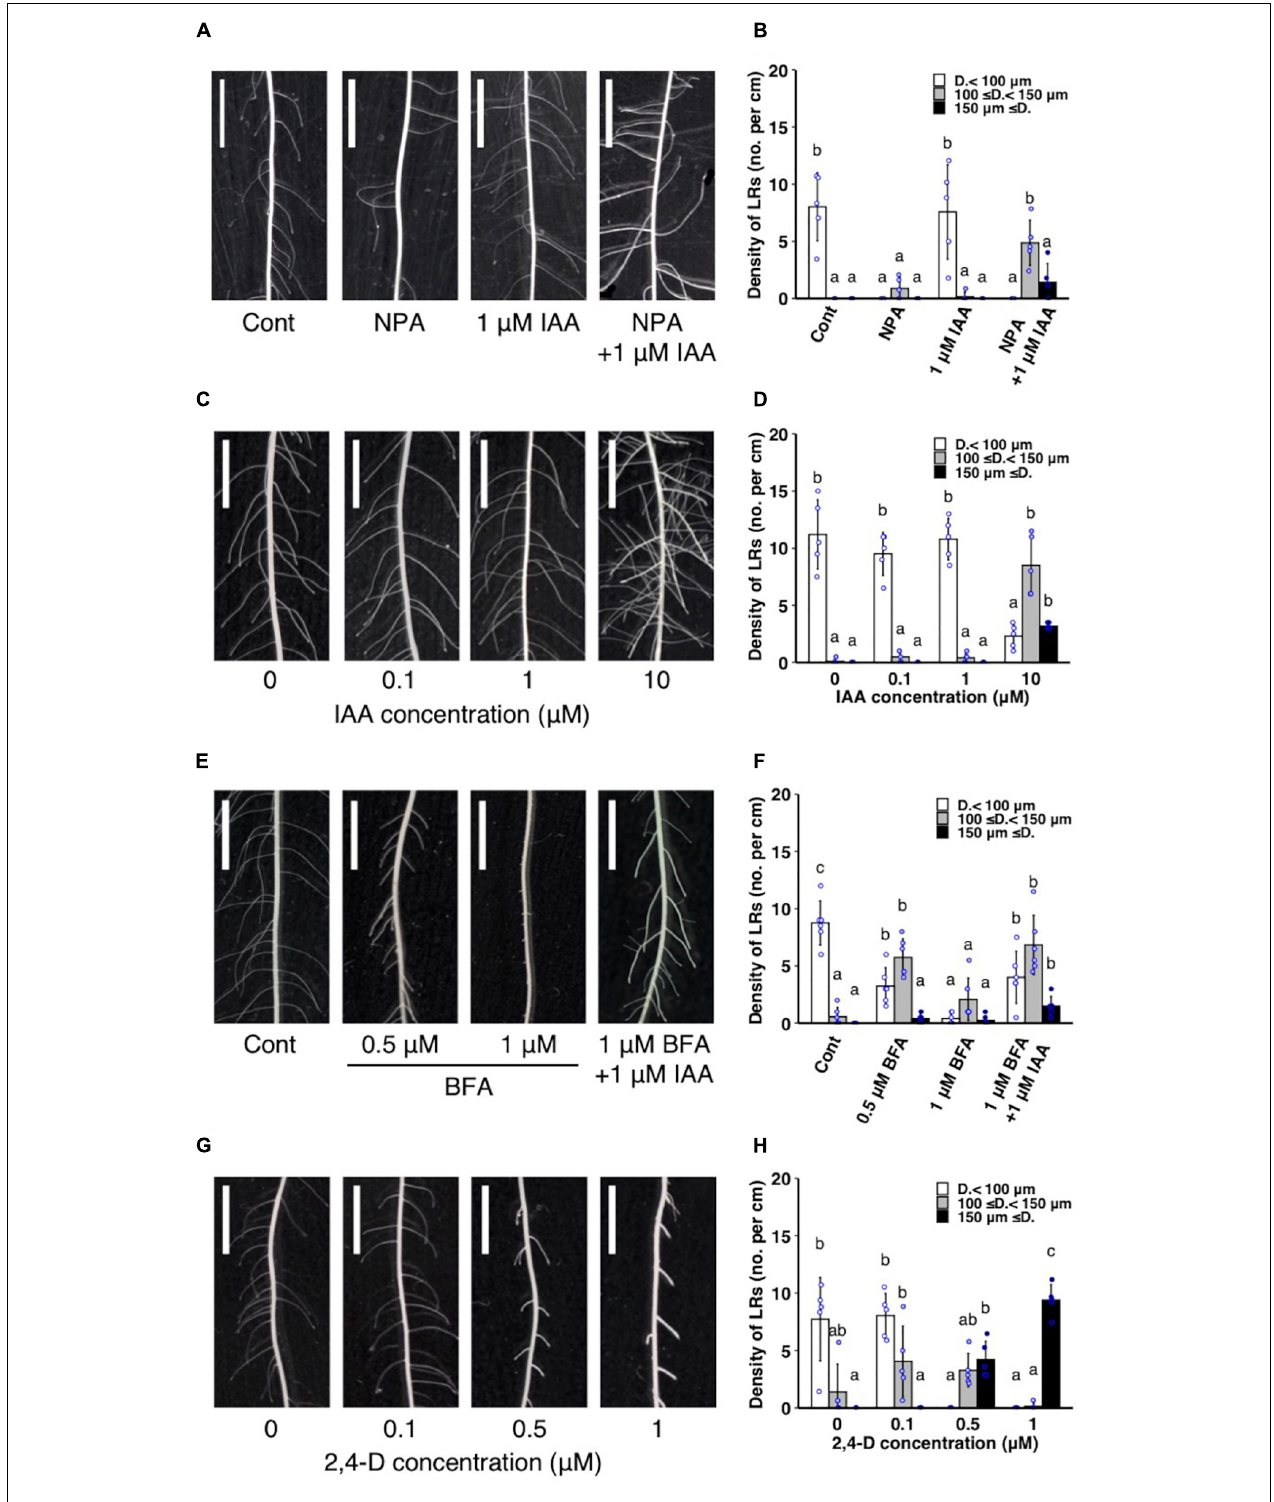
FIGURE 5 | Analysis of the effect of exogenous auxin and chemical inhibitors on lateral root (LR) formation on seminal roots in wild-type rice. (A,B) Treatment of IAA and a polar auxin transport inhibitor NPA. (C,D) IAA treatment. (E,F) Treatment of IAA and a vesicle trafficking inhibitor BFA. (G,H) 2,4-D treatment. (A,C,E,G) LR formation in control and treated plants. Scale bars = 5 mm. (B,D,F,H) Density of LRs in different diameter classes. D., LR diameter. Values represent mean ± SD ( n = 5 independent biological replicates). Different letters indicate significant differences among treatments ( P < 0.05).